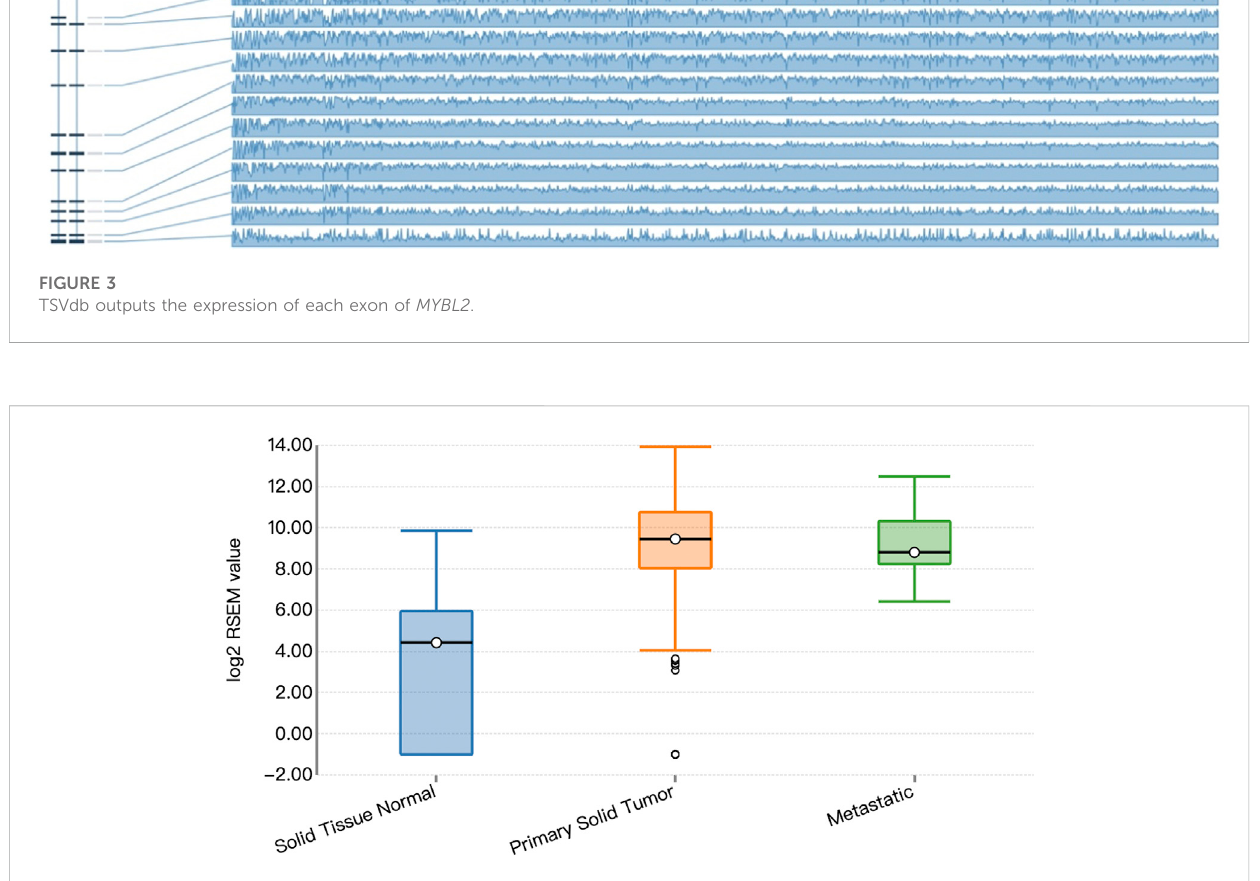
FIGURE 4 Whole exon spliceosome